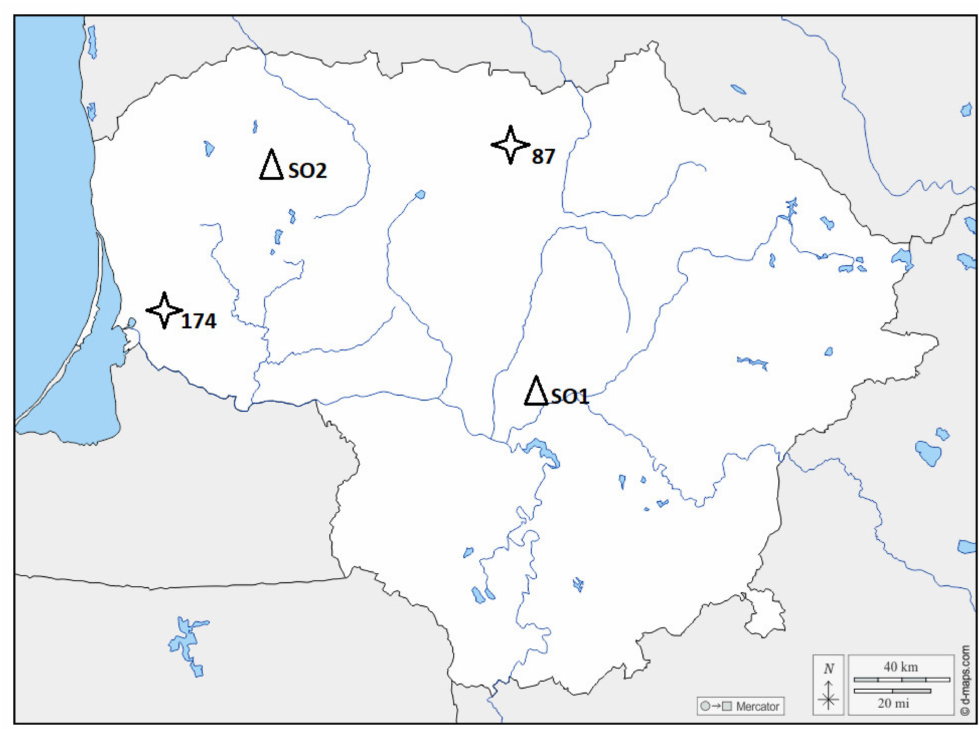
Figure 1. Map of Lithuania showing the seed orchard (marked with ∆ SO1 for 174 and 87 genetic families and ∆ SO2 for the 64 genetic family on the map) and origin sites of the genotypes (marked with an asterisk on the map) used for the study. The origin site of the 64 genetic family cannot be